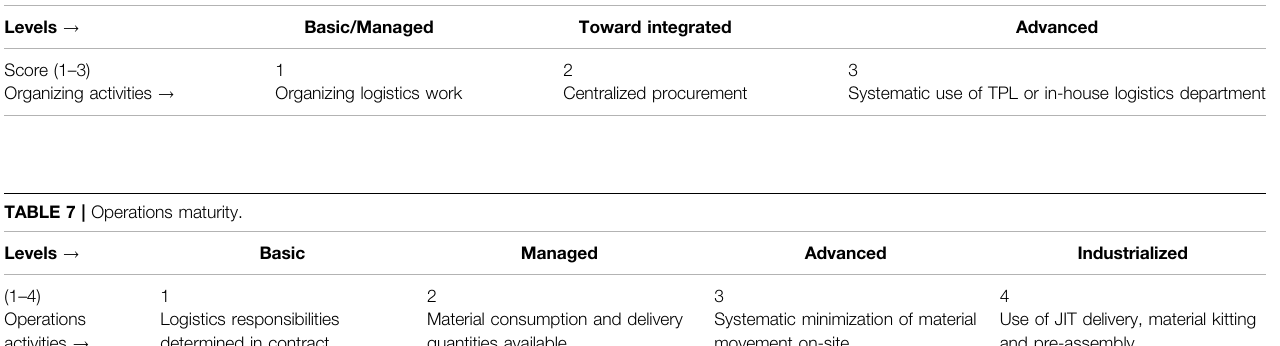
TABLE 6 | Organizing maturity.